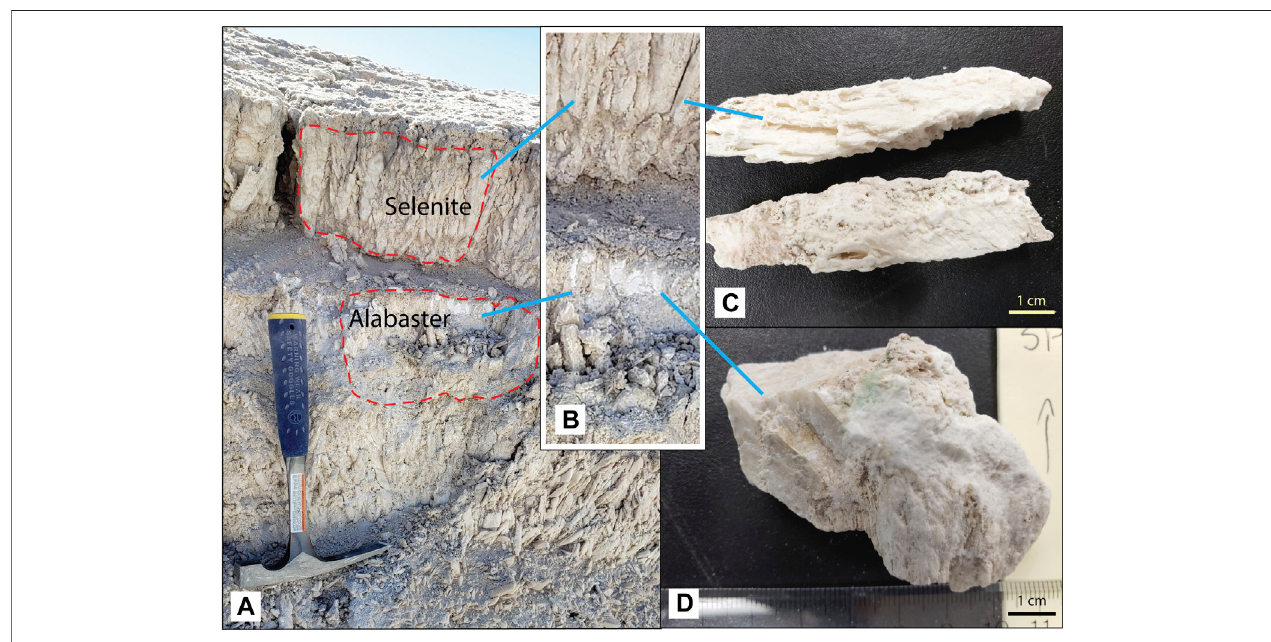
FIGURE 6 | Crystal and alabaster textures. (A) Surface bed of in-place crystals caps sediment package with alabaster domains. (B) Close up of selenite and alabaster in (A) . (C) Selenite crystal. Scale bar is 1 cm. (D) Alabaster. Arrow indicates up direction. Scale bar is 1 cm.